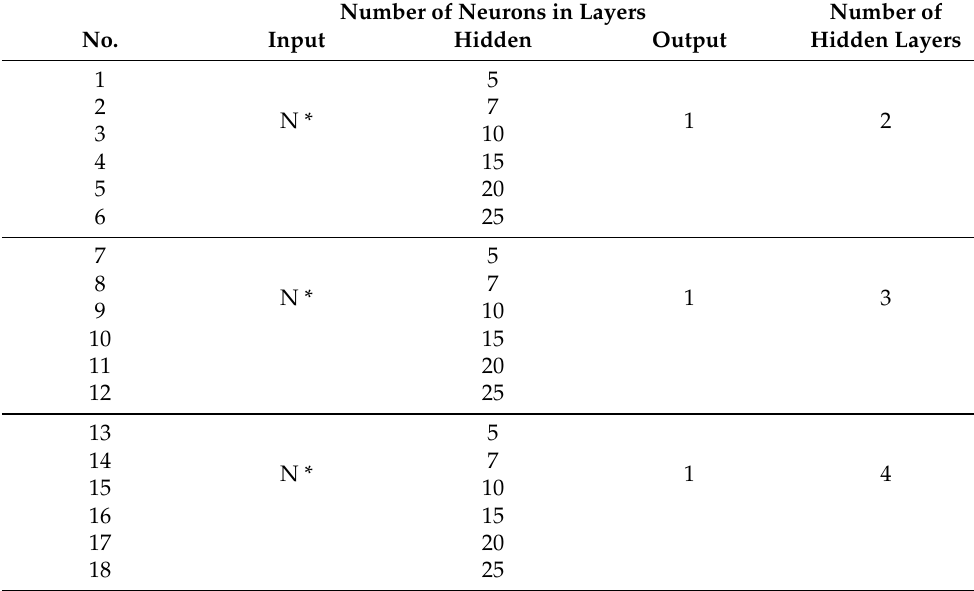
Table 3. Structures of analyzed neural networks. Number of Neurons in Layers Number of Input